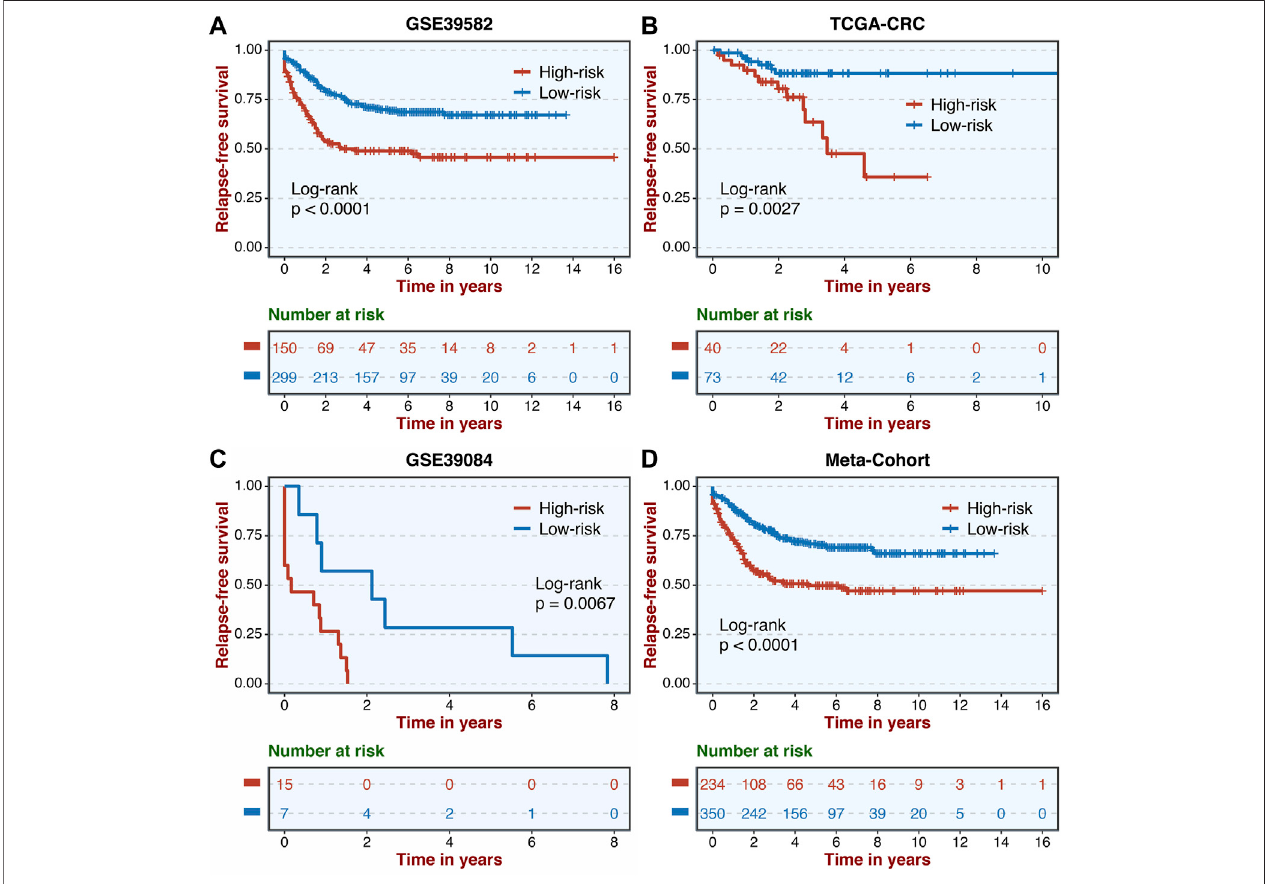
FIGURE 5 | Kaplan – Meier analysis of RFS according to MSSAS. Kaplan – Meier curves of RFS according to the MSSAS in GSE39582 (A) , TCGA – CRC (B) , GSE39084 (C) , and Meta-Cohort (D) .